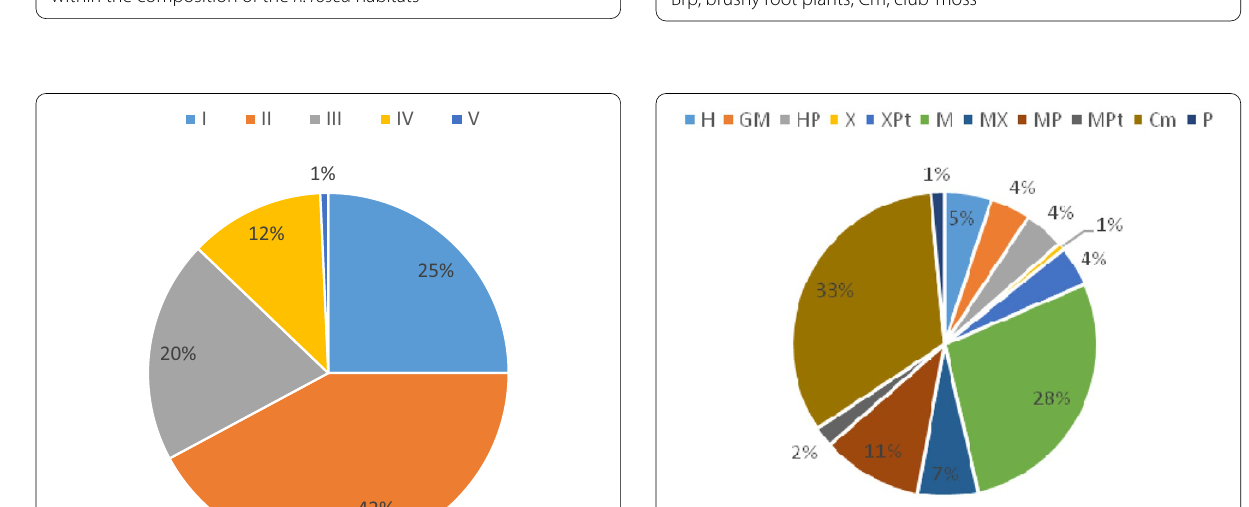
Fig. 9 Composition of the ecological groups in the flora of the R. rosea habitats: H, hygrophytes; GM, hygromesophytes; HP, hygropsychrophytes; X, xerophytes; XPt, xeropetrophyte; MX, mesoxerophytes; MP, mesopsychrophytes; X, xerophytes; XPt, xeropetrophyte; P, psychrophytes; MPt,